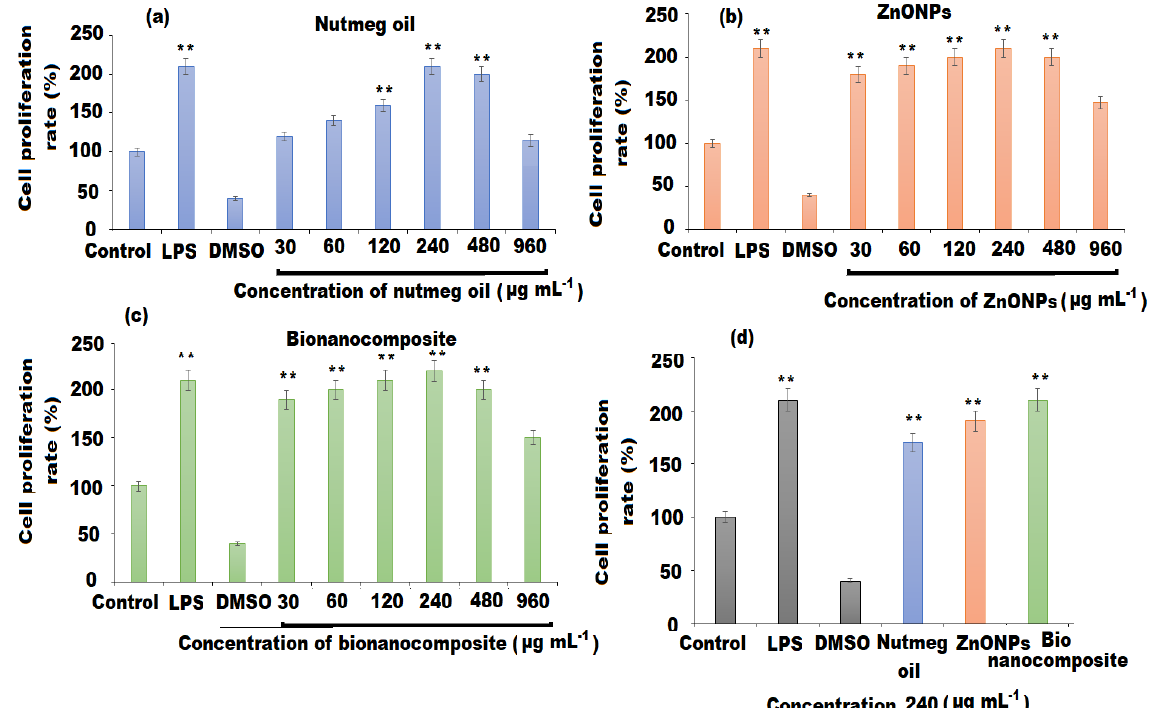
Figure 10. Cell proliferation rate of: ( a ) nutmeg oil ( b ) ZnNPs, ( c ) bionanocomposite, and ( d ) comparative analysis. The mean values and standard deviation (SD) were represented by bars and error bars, respectively for three independent determinations (n = 3). (**) indicate ( p < 0.01 ) compared to the control.